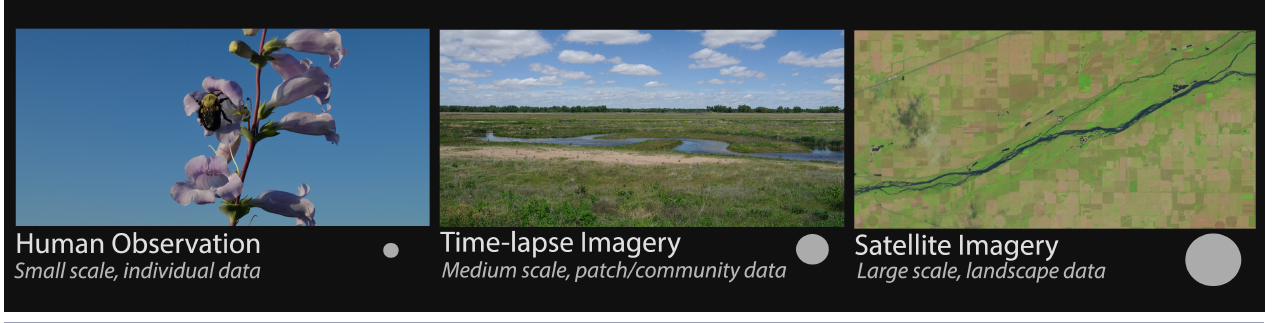
Fig. 9 . Scaling up of in-person, time-lapse imagery and satellite remote sensing